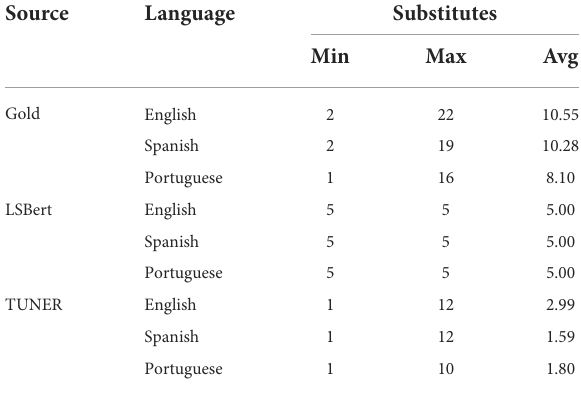
TABLE 7 The statistics for the number of simpler substitutes in gold data and the systems’